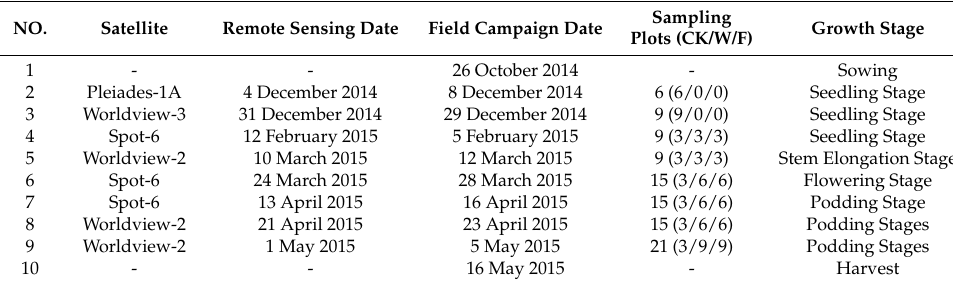
Table 1. Dates of the selected high spatial satellite images, field campaigns, and the sampling plots with corresponding winter oilseed rape growth